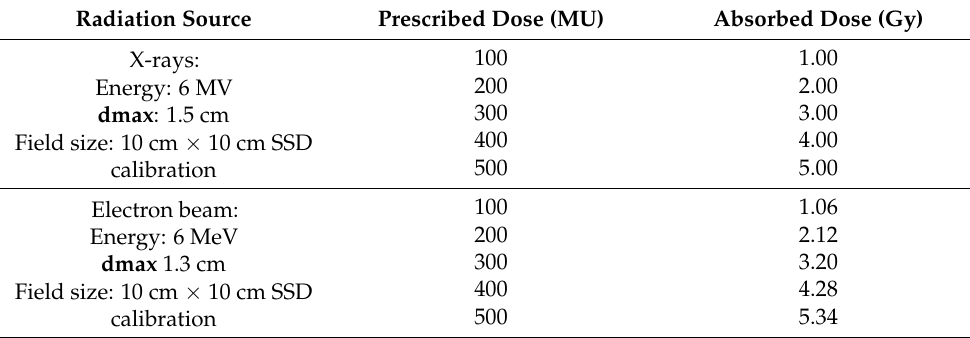
Table 2. Absorbed dose at each film sample for 6 MV photon and 6 MeV electron beam.